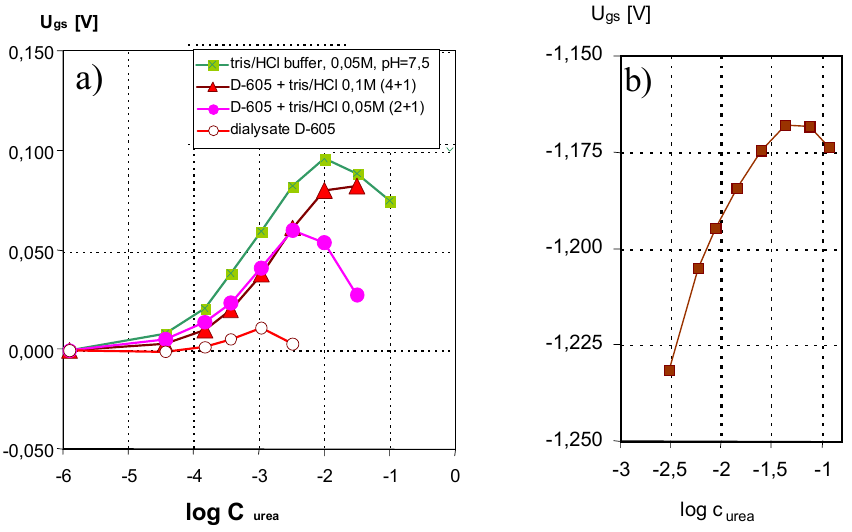
Figure 3. Calibration curves of the urea sensor in dialysate D-605, dialysate mixed with 0.05 M tris/HCl buffer (2:1 v/v), dialysate mixed with 0.1 M tris/HCl buffer (4:1 v/v) and in 0.05 M tris/HCl buffer (a) and in blood plasma mixed with 0.1 M tris/HCl buffer of pH 7.5 (1:2 v/v)